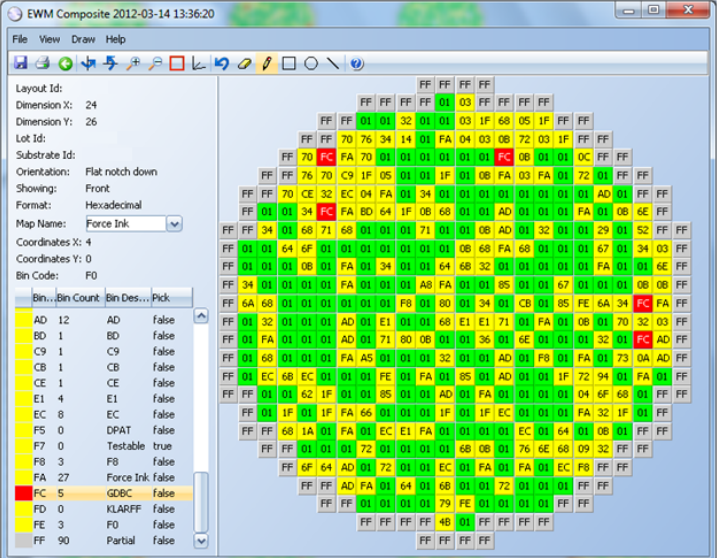
Figure 5. Good Die in a Bad Cluster (GDBC)